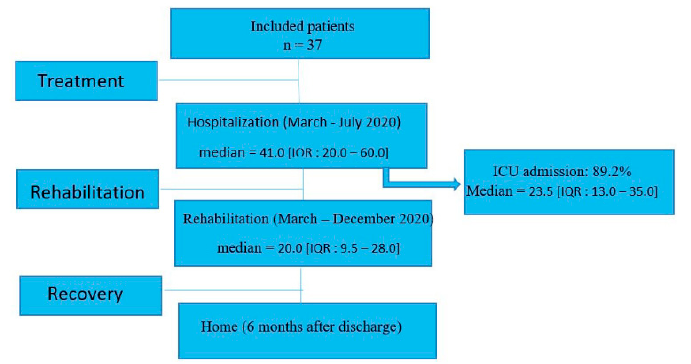
Figure 1. Flow chart of the study.